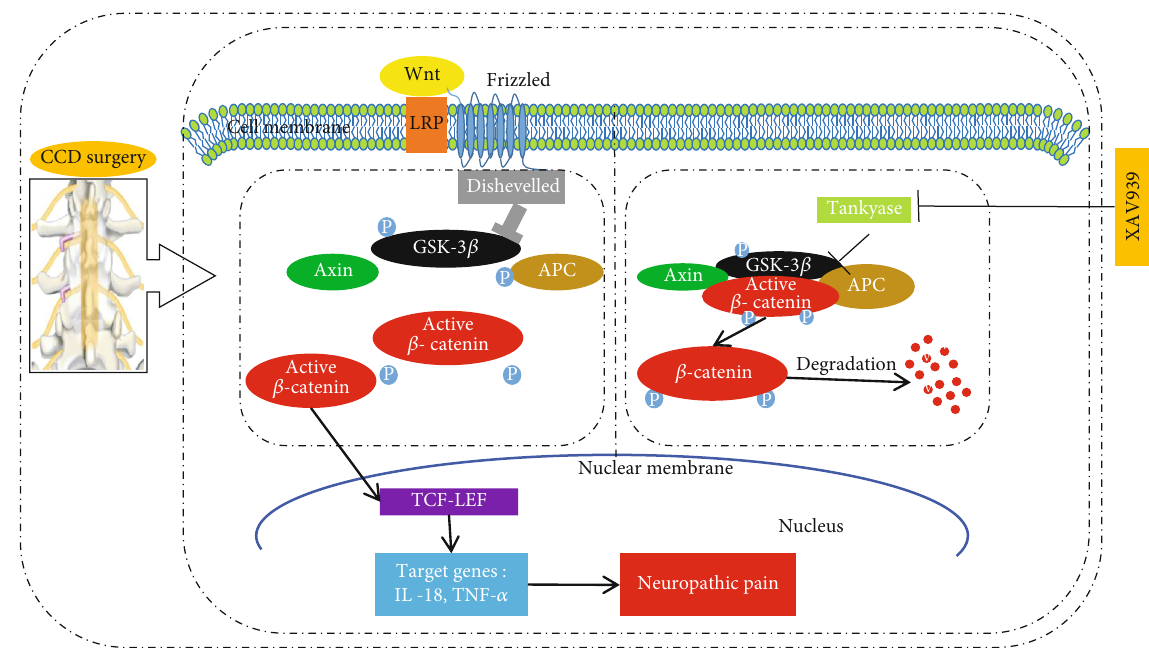
Figure 4: Schematic illustration of the relationship between the Wnt/ β -catenin pathway and neuropathic pain. The relationship between the Wnt/ β -catenin pathway and neuropathic pain in the CCD model was possibly that CCD surgery caused activation of the Wnt/ β -catenin pathway; then, active β -catenin accumulated in the cytoplasm and translocated into the nucleus. Subsequently, the transcription of the target genes TNF- α and IL-18 increased, leading to neuropathic pain fi nally, while the Wnt/ β -catenin inhibitor XAV939 can suppress this process, relieving CCD-induced neuropathic